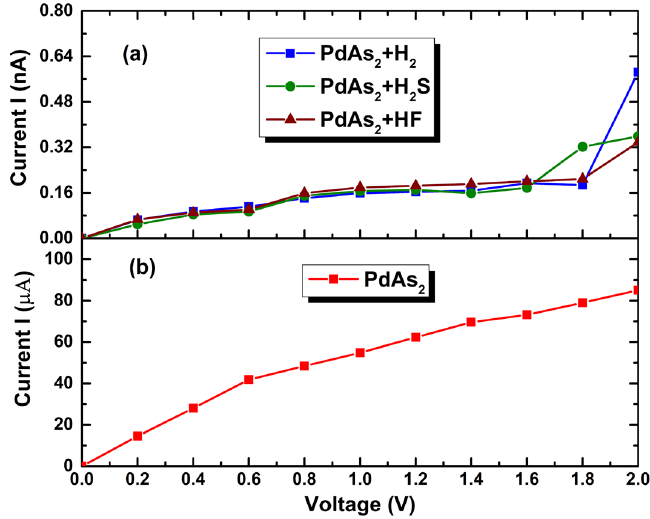
Figure 6. The current–voltage charateristics of adsorbed ( a ) H 2 , H 2 S and HF gas molecules, ( b ) bare PdAs 2